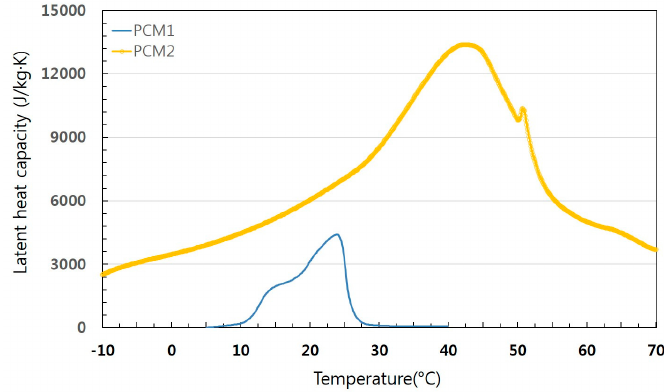
Figure 1. Latent heat capacities of prepared PCMs.